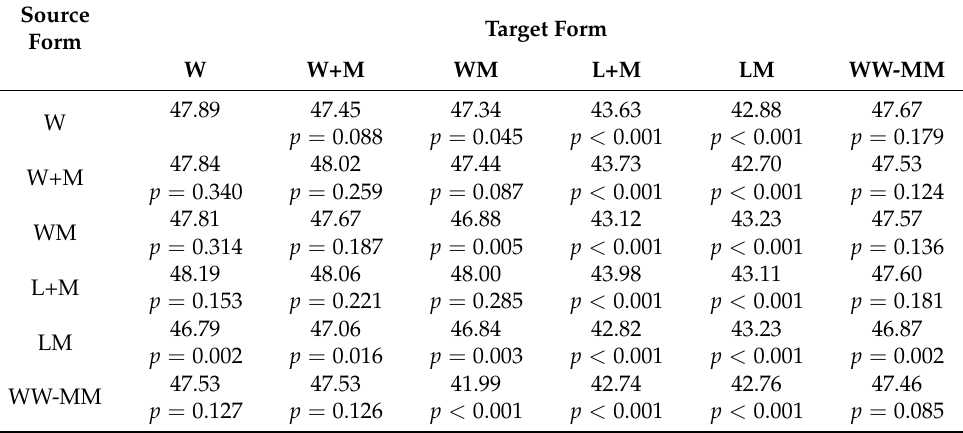
Table 11. BLEU scores and p -values for the translations from Slovene to English for different systems on the ParaCrawl